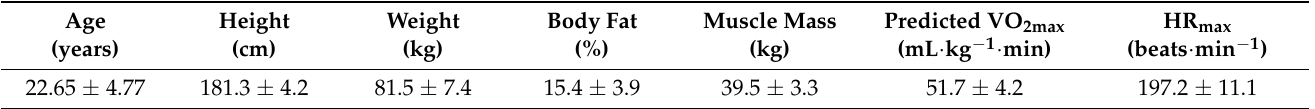
Table 1. Physical characteristics of the volunteers ( n =